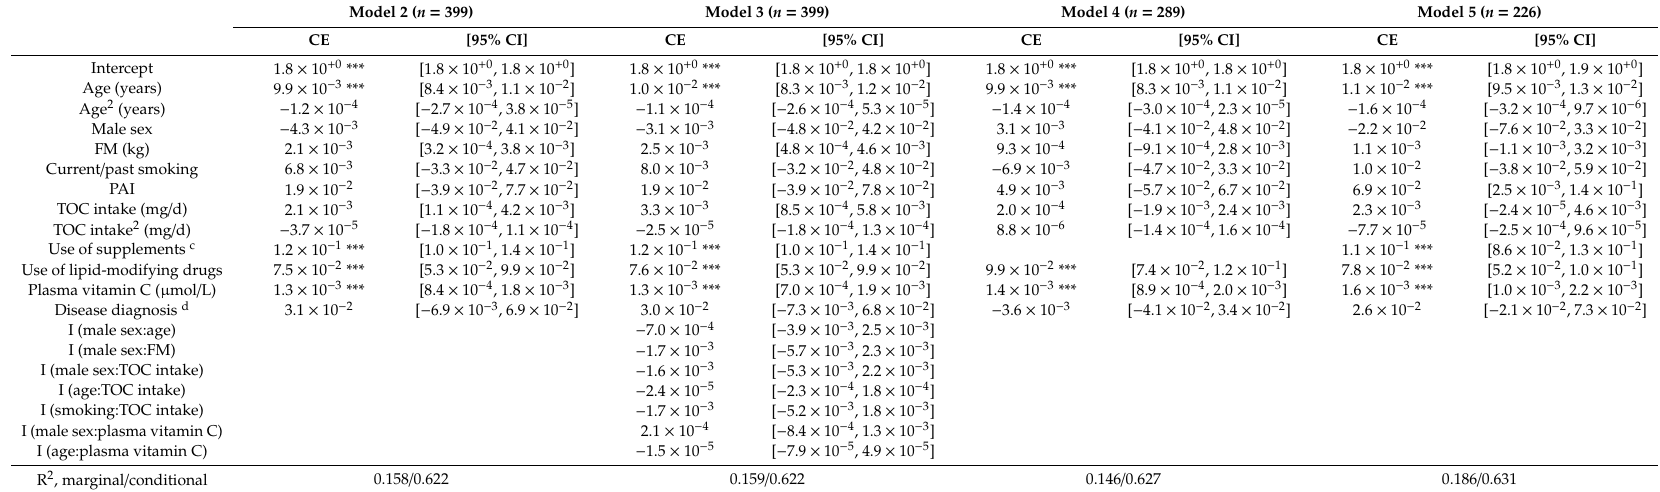
Table 4. Results of linear mixed-e ff ects models for determinants of the log α -tocopherol / total cholesterol ratio a,b